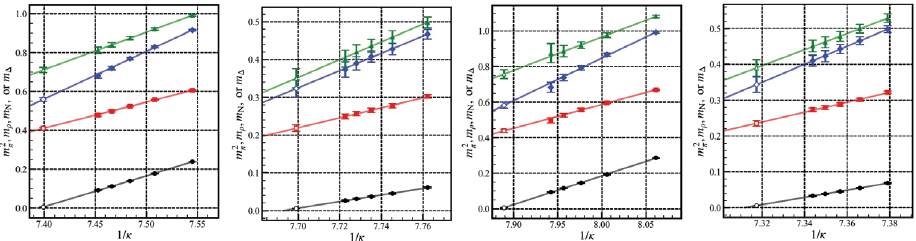
Figure 2. Hadron mass measurement (a) from the original gauge configuration; (b) under the (cid:3) A = 0 pro- jection in the Coulomb gauge; (c) under the eigenmode projection with 5 % low-lying FP eigenmodes; (d) under the eigenmode projection with 95 % high-lying FP